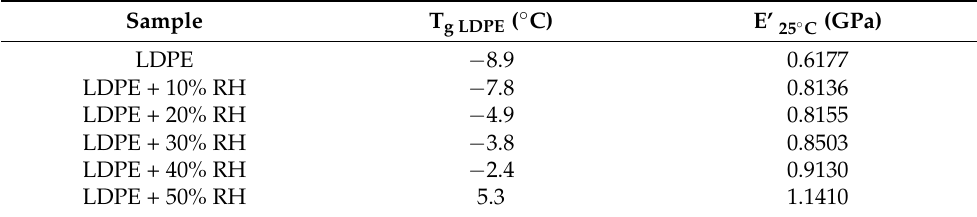
Figure 12. Loss modulus (E’’) as a function of temperature of neat LDPE, and LDPE/RH biocom- posites containing different RH content. Table 6. Results of DMA measurement for the neat LDPE and LDPE/RH biopolymers.